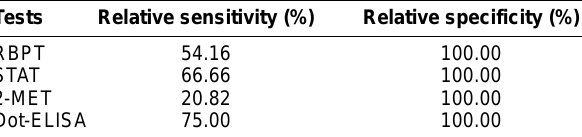
Table-4: Seroprevalence of brucellosis among goats (n=252) in different regions of Karnataka Region